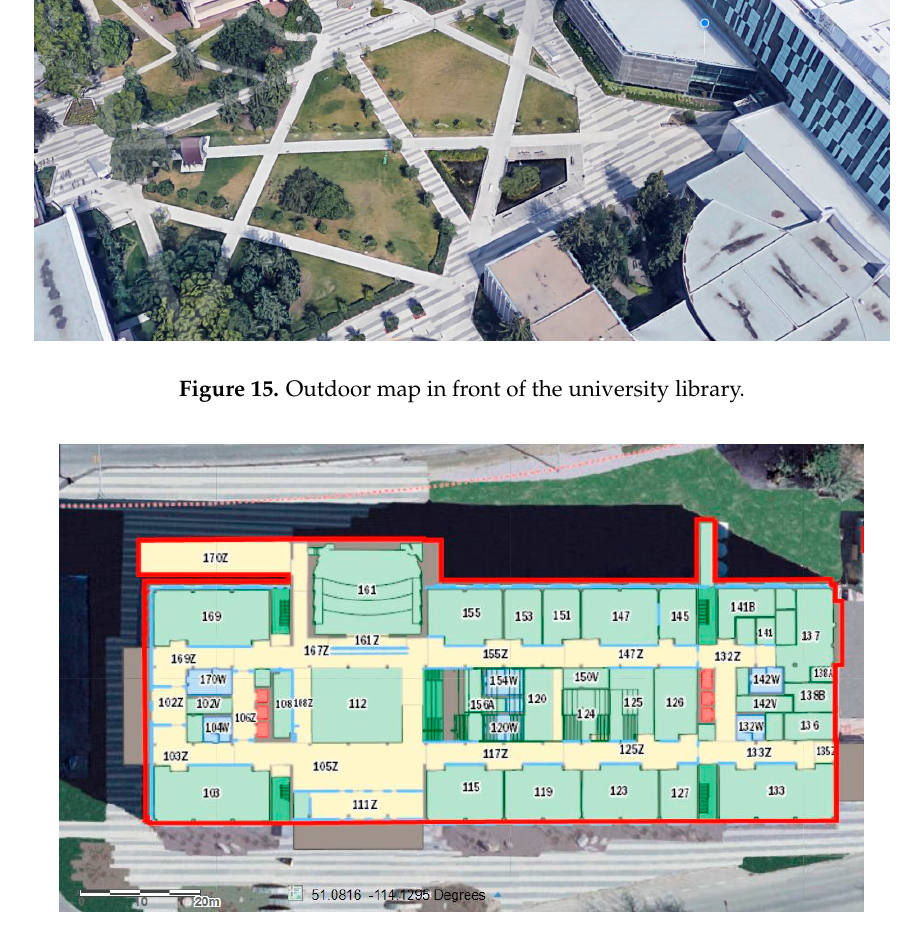
Figure 16. Indoor map of the Energy Environment Experimental Learning (EEEL) building where tests were carried out.